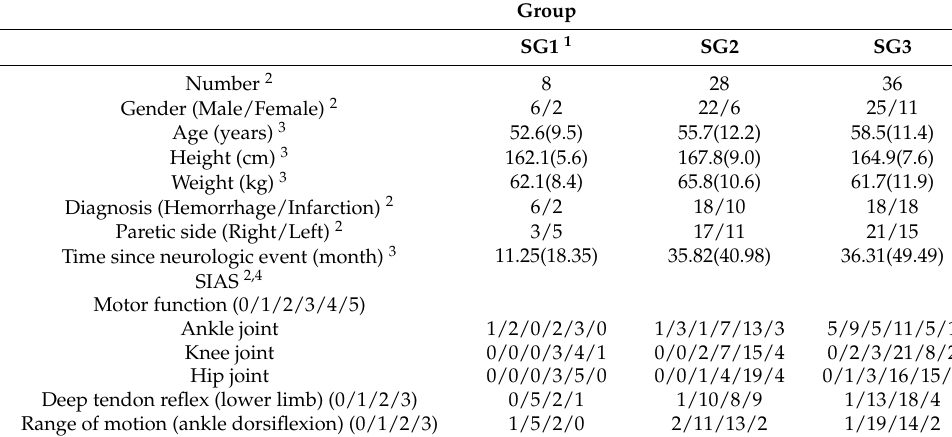
Table 5. Demographic and clinical features of patients in the three subgroups.